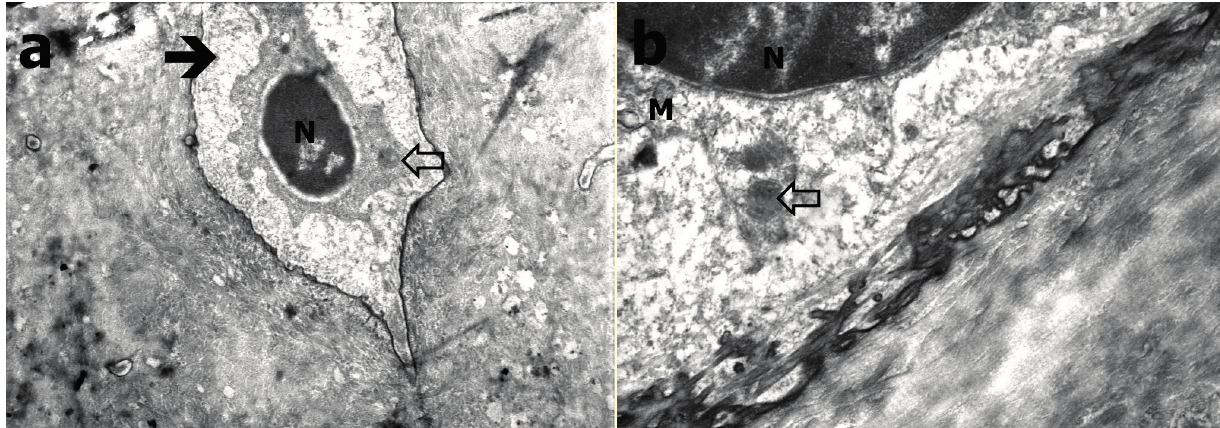
Figure 5. TEM evaluation of Group A ( a ) Heterochromatic osteocyte (black arrow), decreased and condensed cytoplasm with round appearances (white arrow; at 26K×); ( b ) Round appearances within cytoplasm (white arrow), mitochondria (M) and nucleus (N; at 56K×).